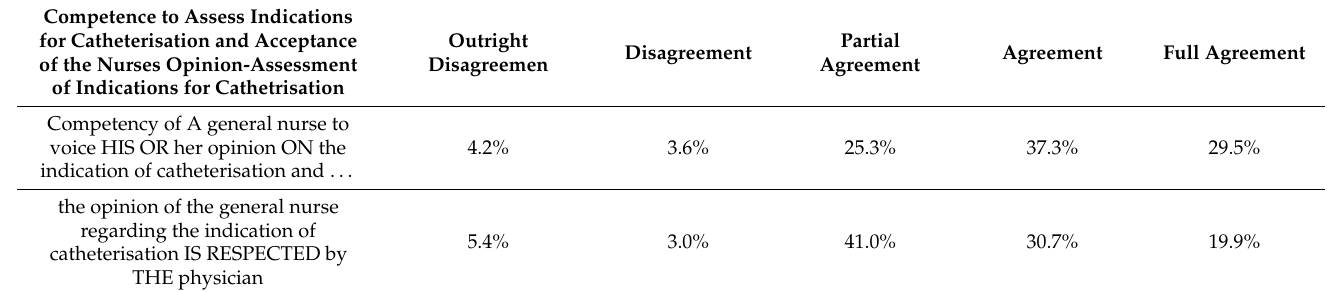
Table 2. Responses to items related to “competency to evaluate indications for catheterisation and the physician respects their